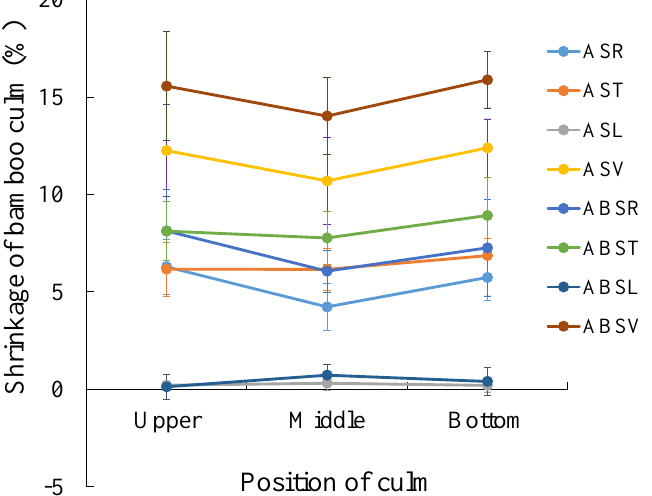
Figure 5. The shrinkage rate of the culm wall in different culm position. ASR, air-drying shrinkage in radial direction; AST, air-drying shrinkage in tangential direction; ASL, air-drying shrinkage in longitudinal direction; ASV, air-drying shrinkage of volume; ABSR, absolute-drying shrinkage in radial direction; ABST, absolute-drying shrinkage in tangential direction; ABSL, absolute-drying shrinkage in longitudinal direction; ABSV, absolute-drying shrinkage in volume.